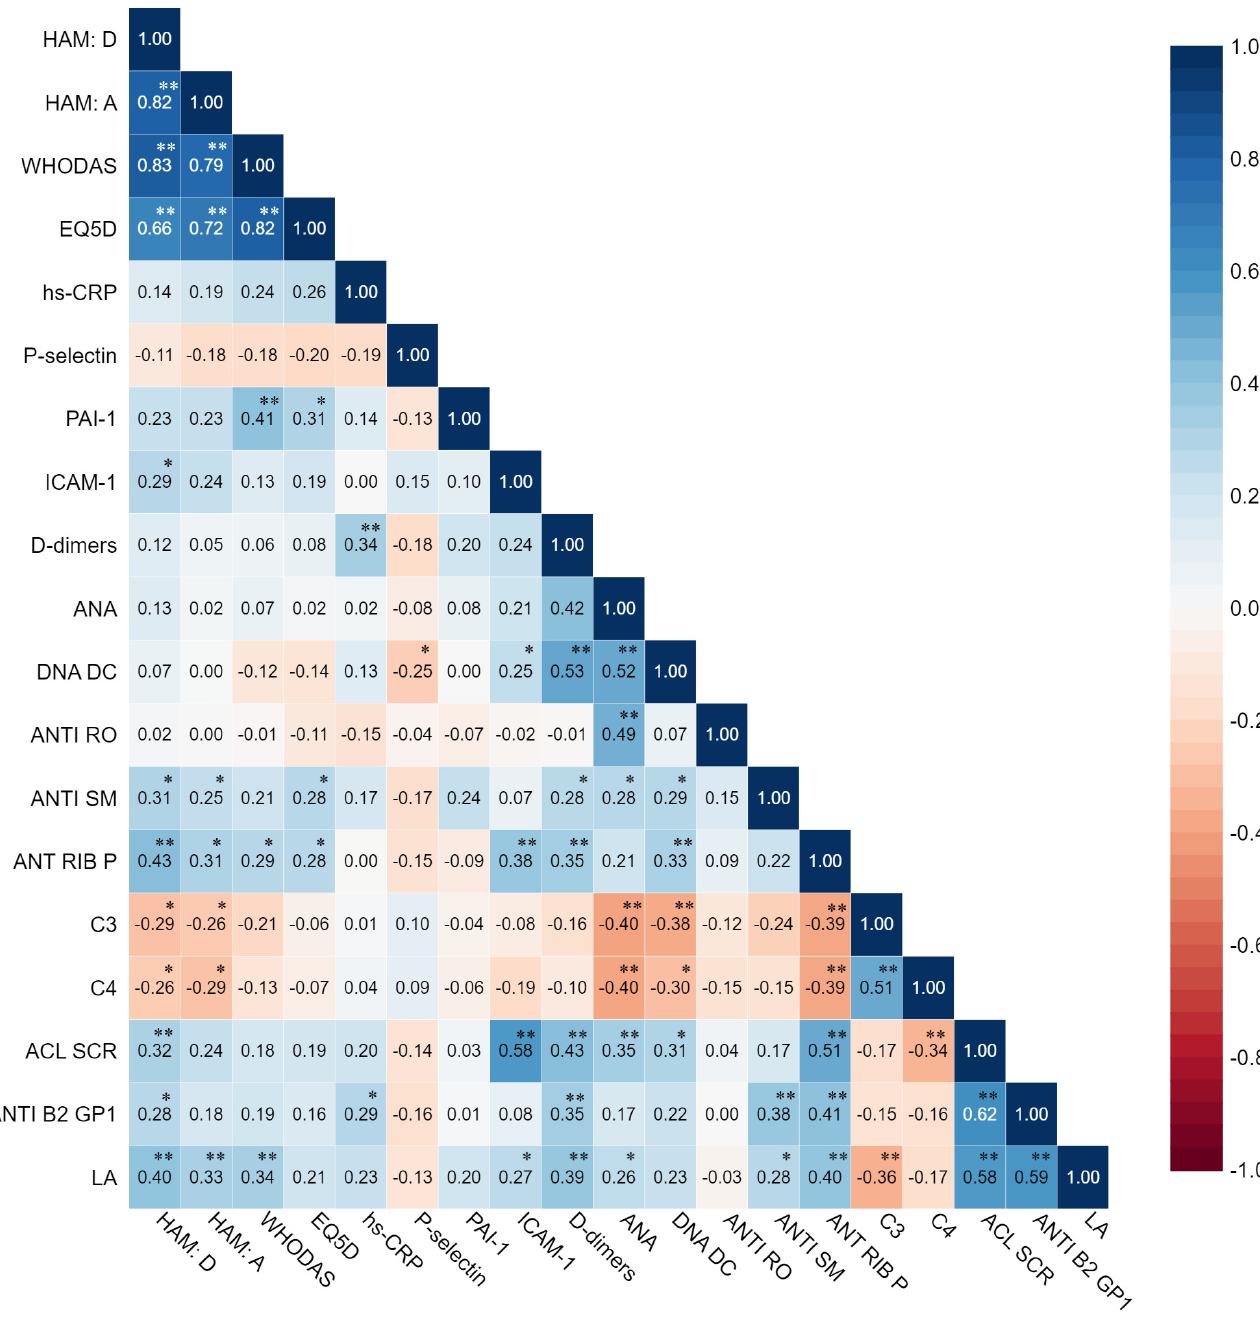
Figure 3. Correlation heatmap of biomarkers associated with thrombotic and inflammation path- ways and depression, anxiety, disability and quality of life in SLE subjects (** p < 0.01, * p <